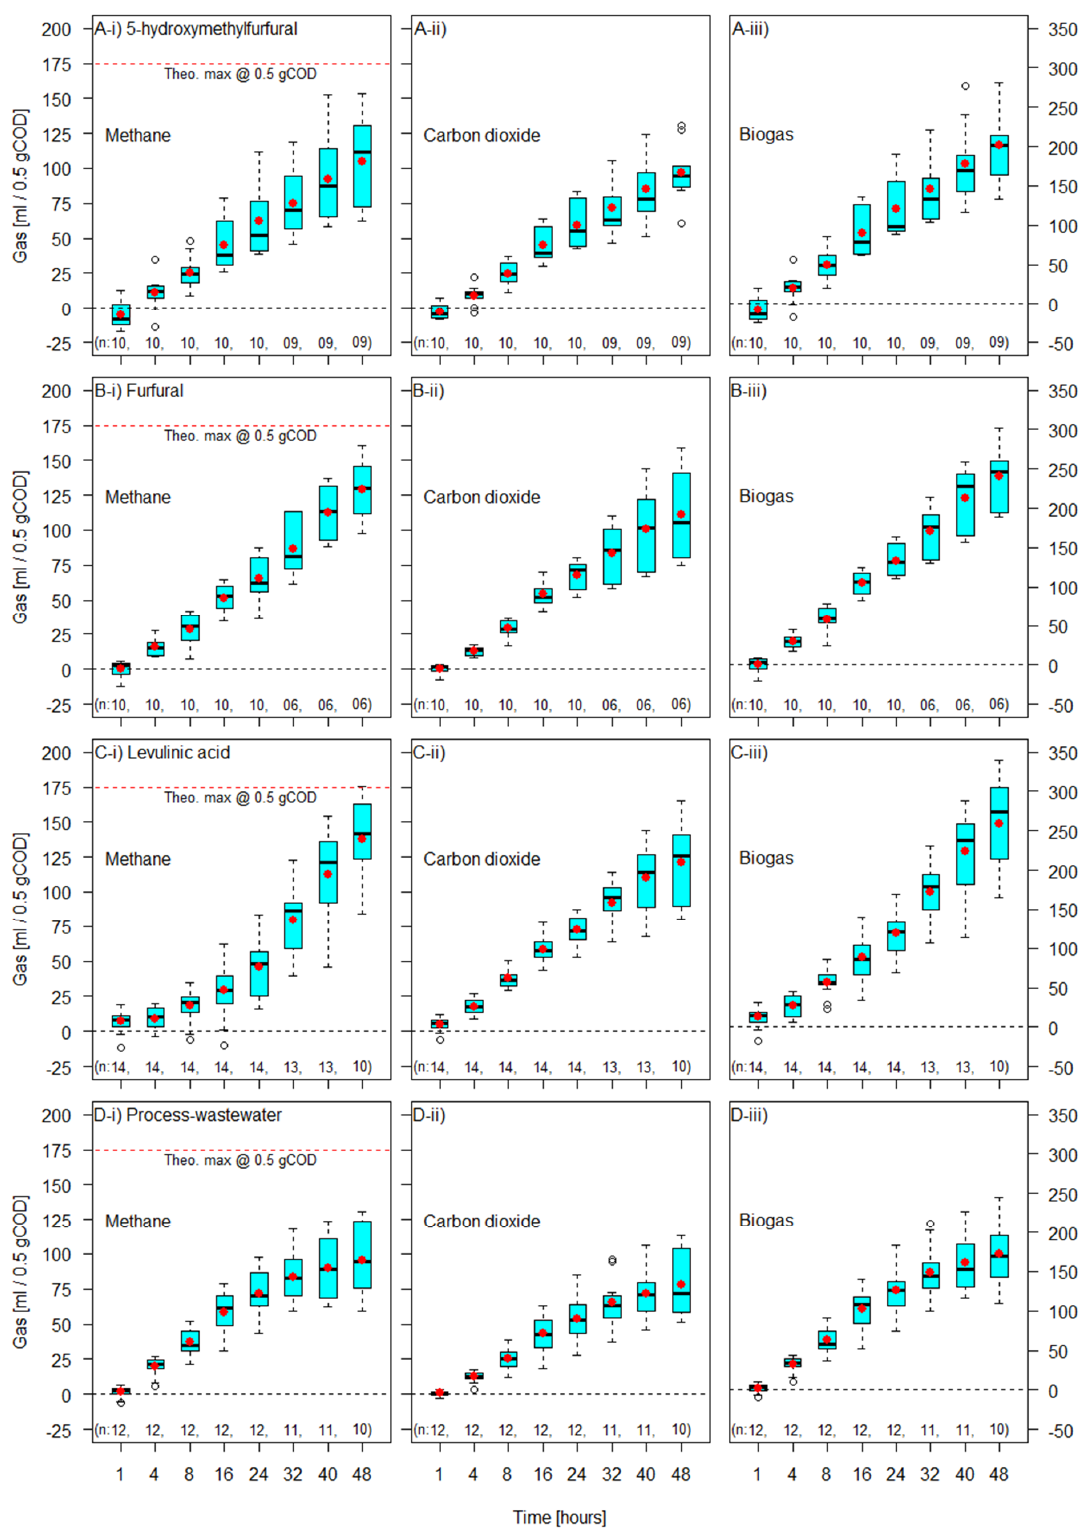
Figure 3. Cumulative gas production (methane ( i ), carbon dioxide ( ii ), and biogas ( iii )) in a continuous anaerobic process at the given time slot for ( A ) 5-hydroxymethylfurfural, ( B ) furfural, ( C ) levulinic acid, and ( D ) process-wastewater. The box plot is characterized by the minimum, 25% quartile, mean, median, 75% quartile, and maximum value.